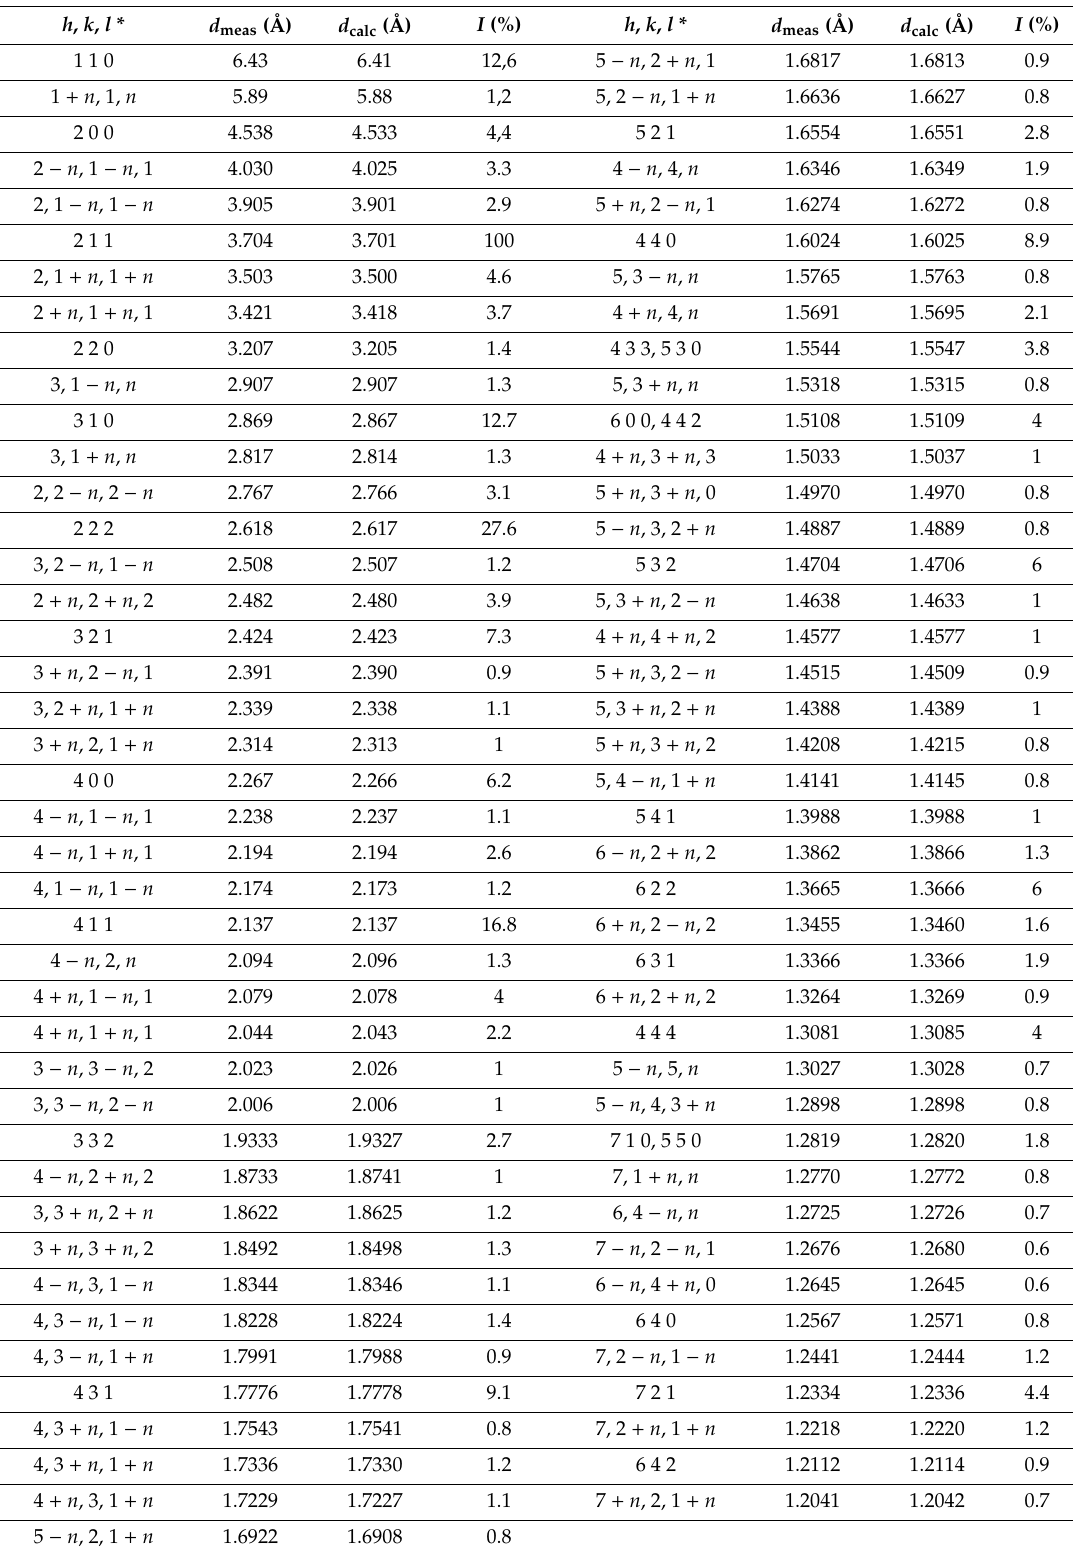
Table 4. Powder X-ray di ff raction data of the KL